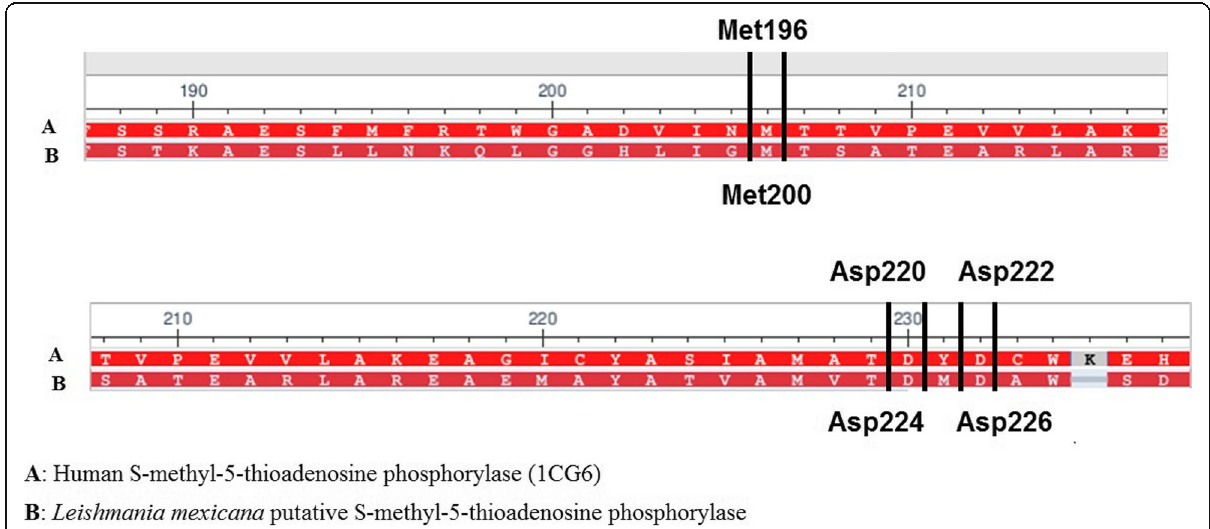
Fig. 2 (a) Human and ( b ) L. Mexicana S-methyl-5-thioadenosine phosphorylase binding site